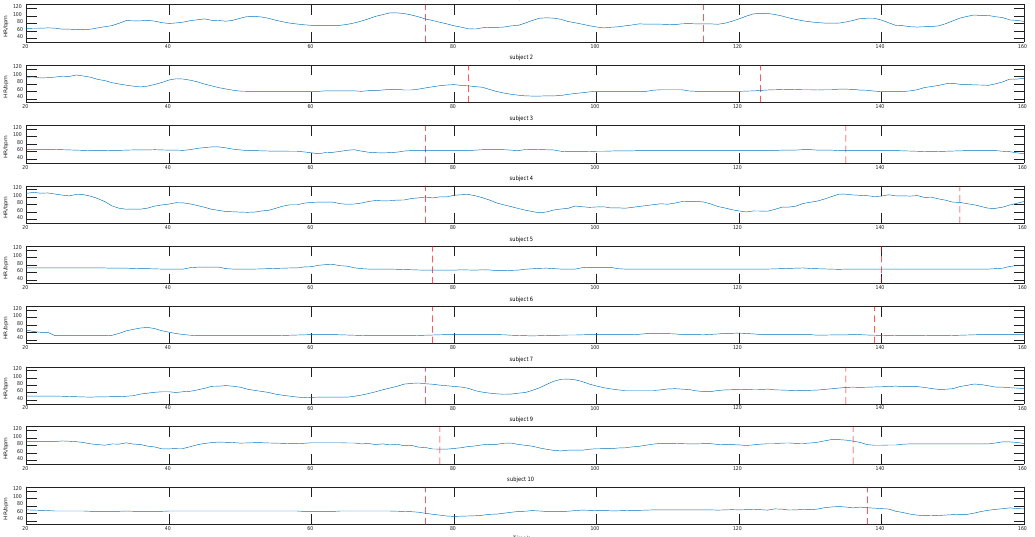
Figure 9. Heart rate changes when subjects were stimulated.